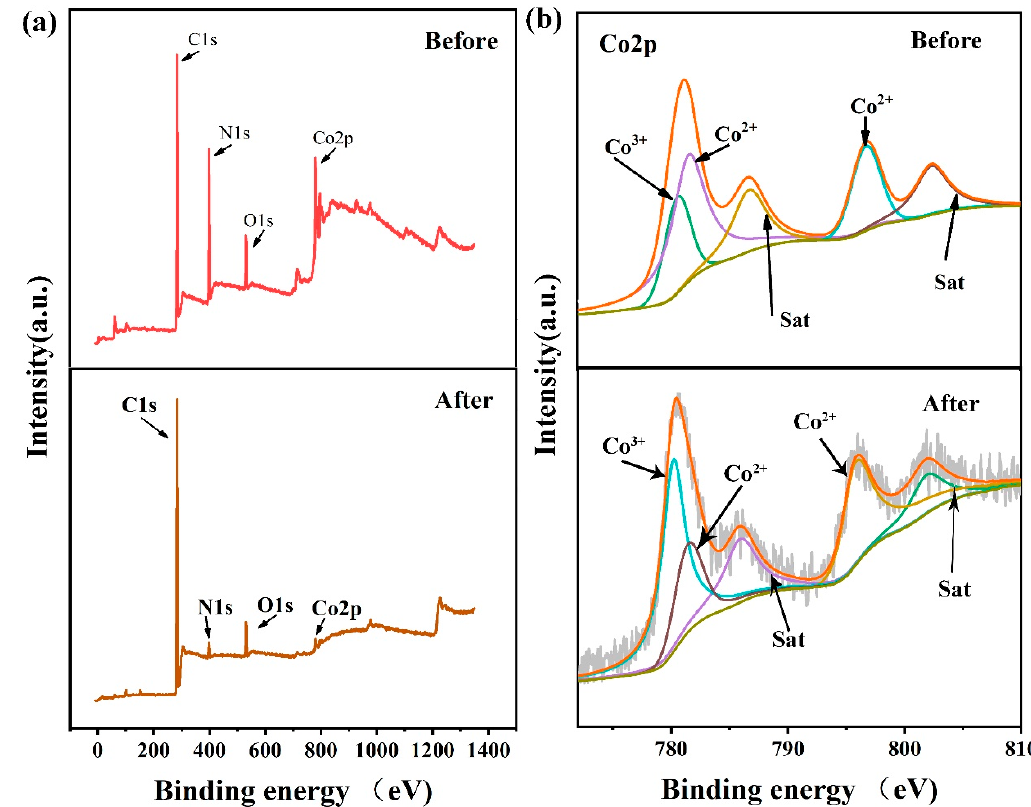
Figure 7. X-ray photoelectron spectroscopy (XPS) spectra of the Co-ZIFs particles: ( a ) full-range scan of the samples, ( b ) Co2p core level.